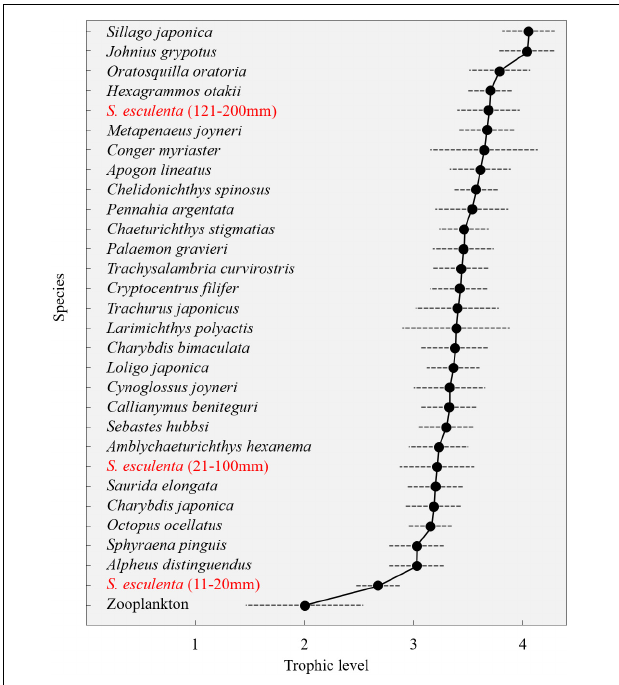
FIGURE 5 | Trophic position estimates were calculated using δ 15 N data of each